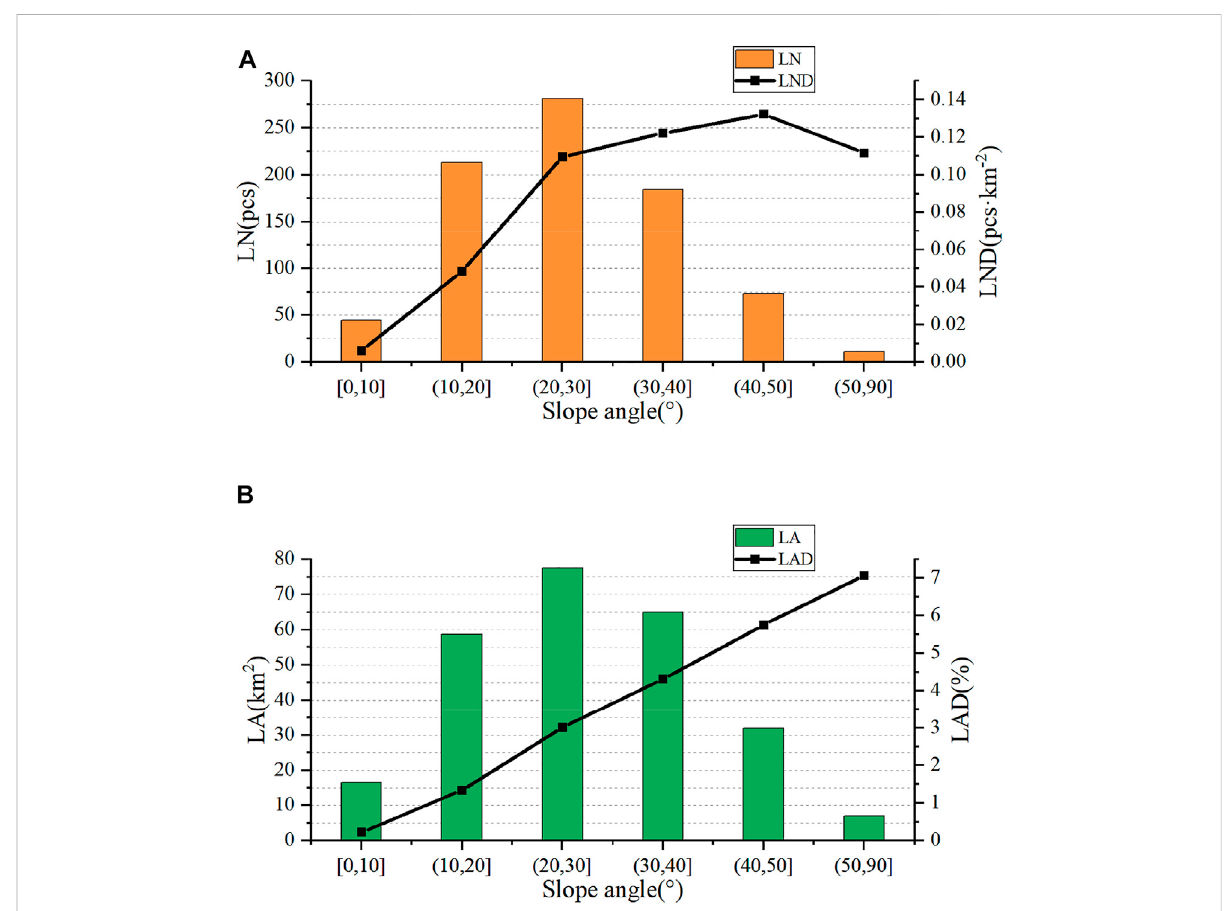
FIGURE 5 The correlations between slope angle and landslide distribution. (A) LN and LND; (B) LA and